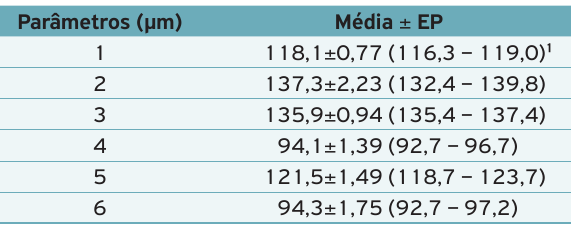
¹Intervalo de Variação. 1: altura dos espiráculos posteriores em vista lateral; 2: largura dos espiráculos posteriores em vista lateral; 3: diâmetro do espiráculo posterior direito em vista dorsal; 4: distância entre os espiráculos posteriores em vista dorsal; 5: altura da base da